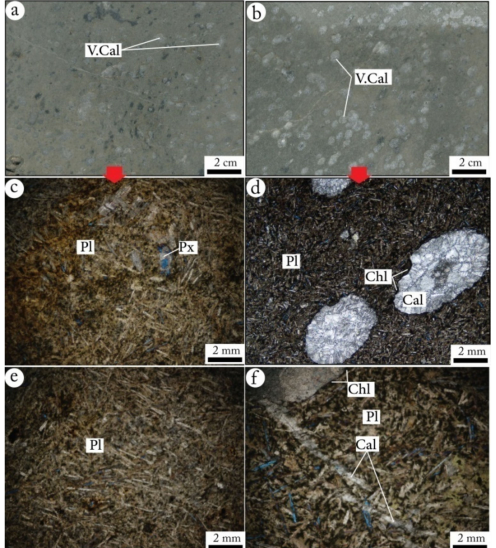
Figure 7. Macroscopic view of pillow-lavas less riche ( a ) andvery rich ( b ) in vacuoles of calcite, and microphotographs of this facies in transmitted light with crossed nicols ( c – f ). V.Cal: vacuoles of calcite, Pl: plagioclase, Cal: calcite, Chl: chlorite,